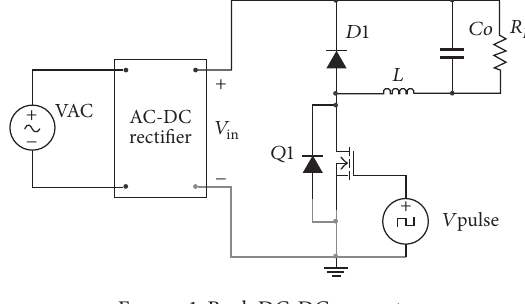
Figure 1: Buck DC-DC converter.